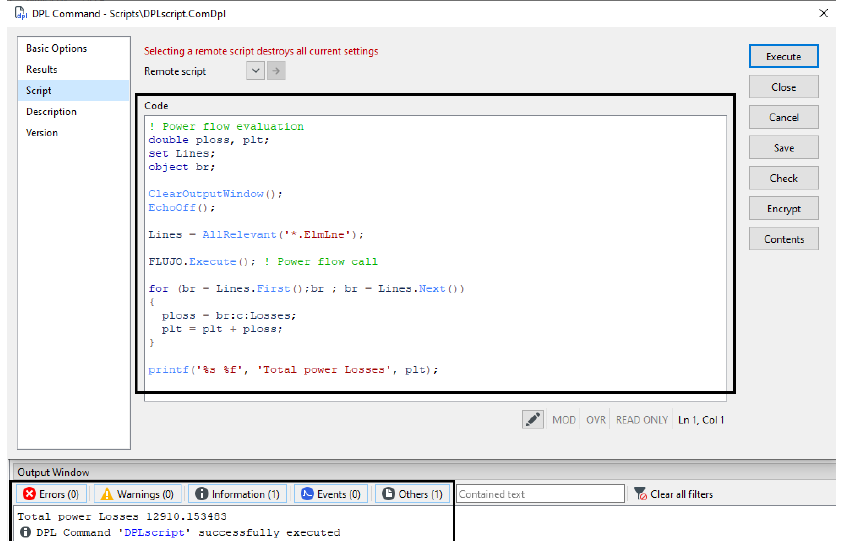
Figure 2. Example of an AC load flow loss calculation (evaluated using Newton–Raphson) in DIgSILENT Programming